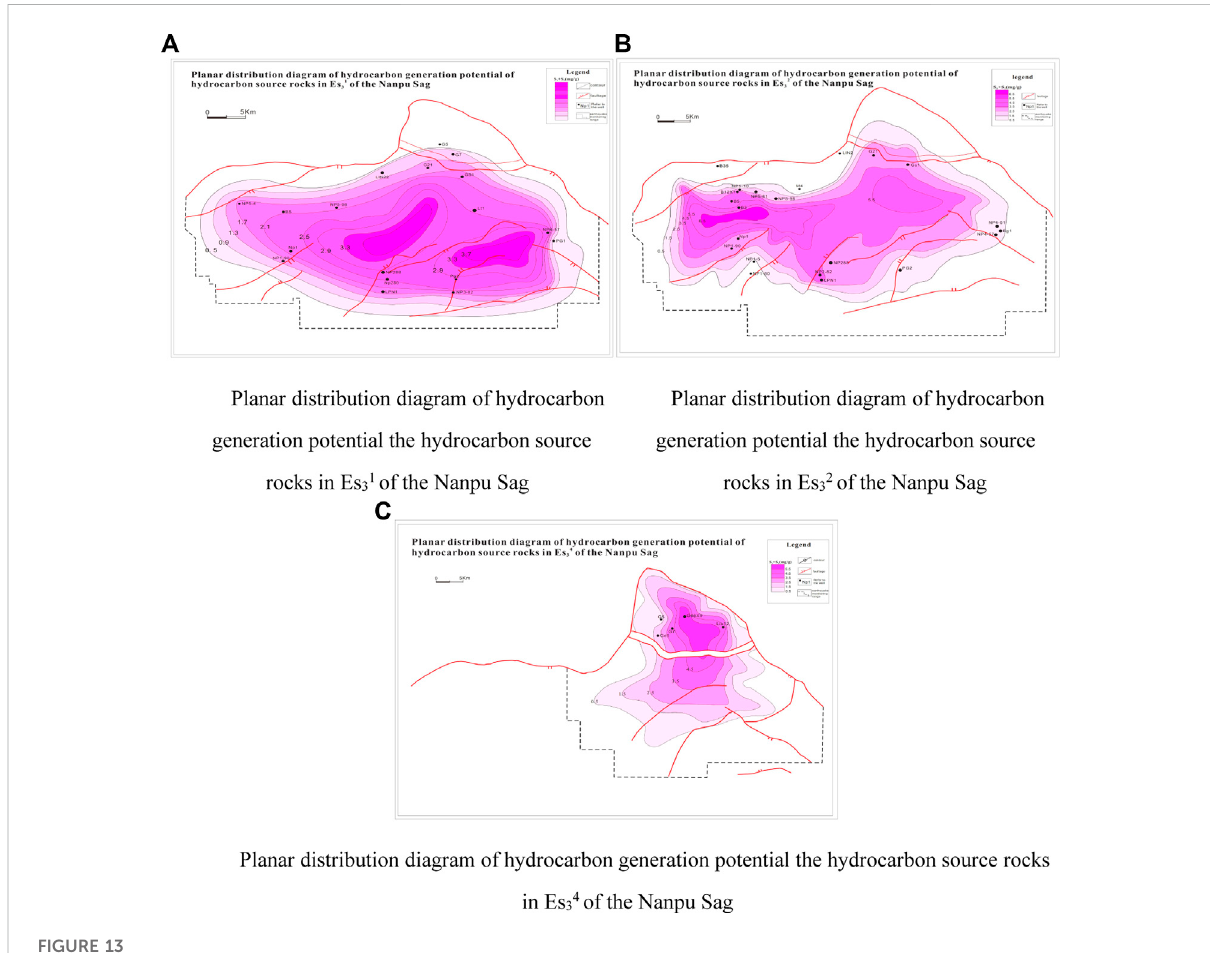
FIGURE 13 PlanepredictionmaphydrocarbongenerationpotentialofEs 3 sourcerocksofNanpuSag. (A) PlanviewofthehydrocarbonpotentialoftheEs 3 1 sub-section. (B) Plan view of the hydrocarbon potential of the Es 3 2 sub-section. (C) Plan view of the hydrocarbon potential of the Es 3 4